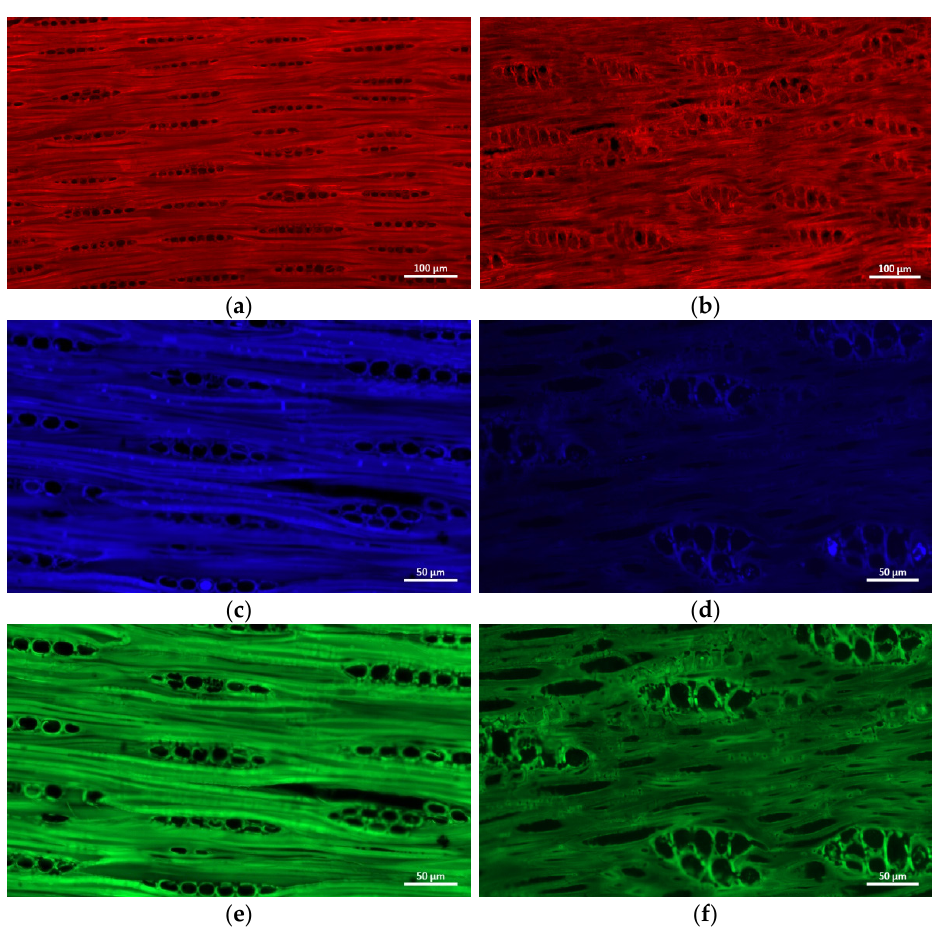
Figure 5. The auto-fluorescence images of the longitudinal sections of pterocarpus bracelet (PB) ( a , c , e ) and P. Santalinus ( b , d , f ) at different excitation wavelengths ( a , b : 488 nm; c , d : 405 nm; e , f : 500